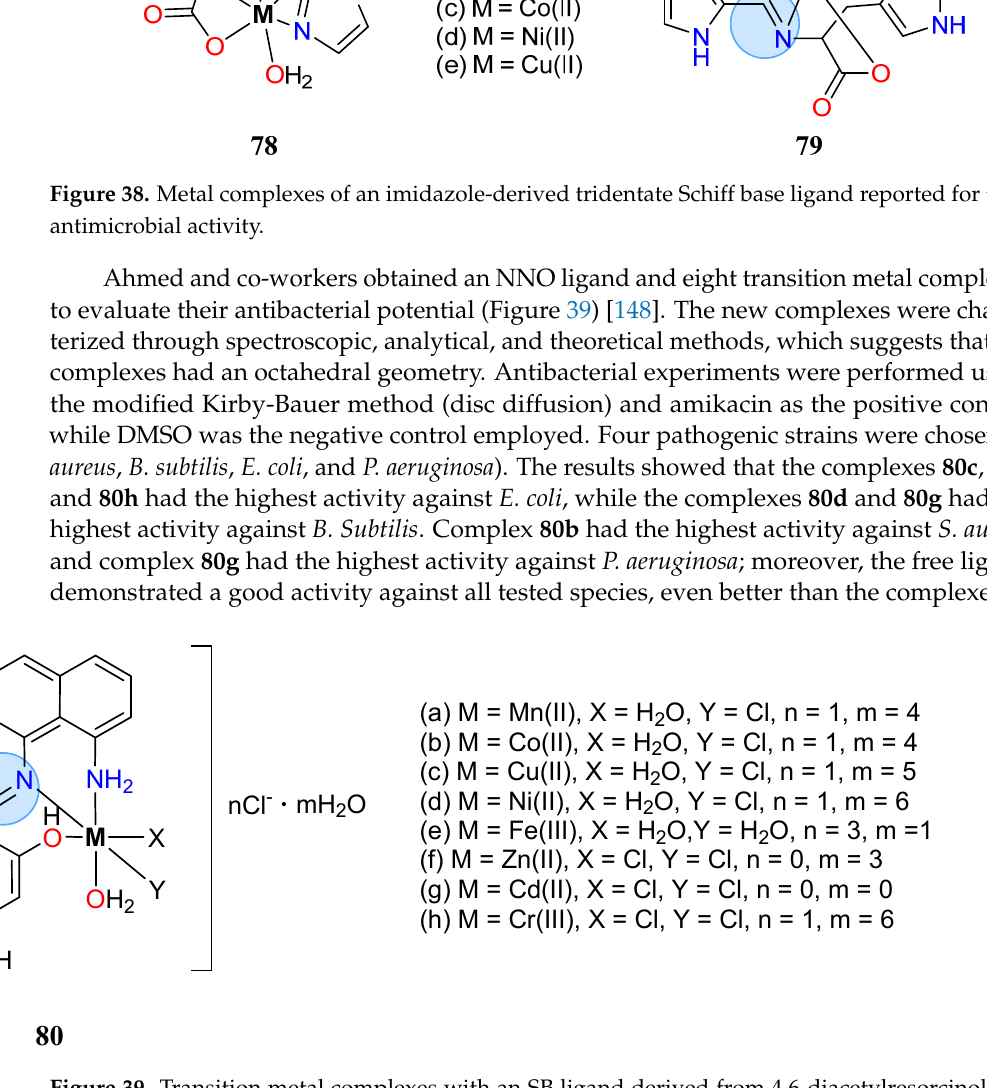
Figure 39. Transition metal complexes with an SB ligand derived from 4,6 ‐ diacetylresorcinol and 1,8 ‐ naphthalenediamine with antibacterial properties.